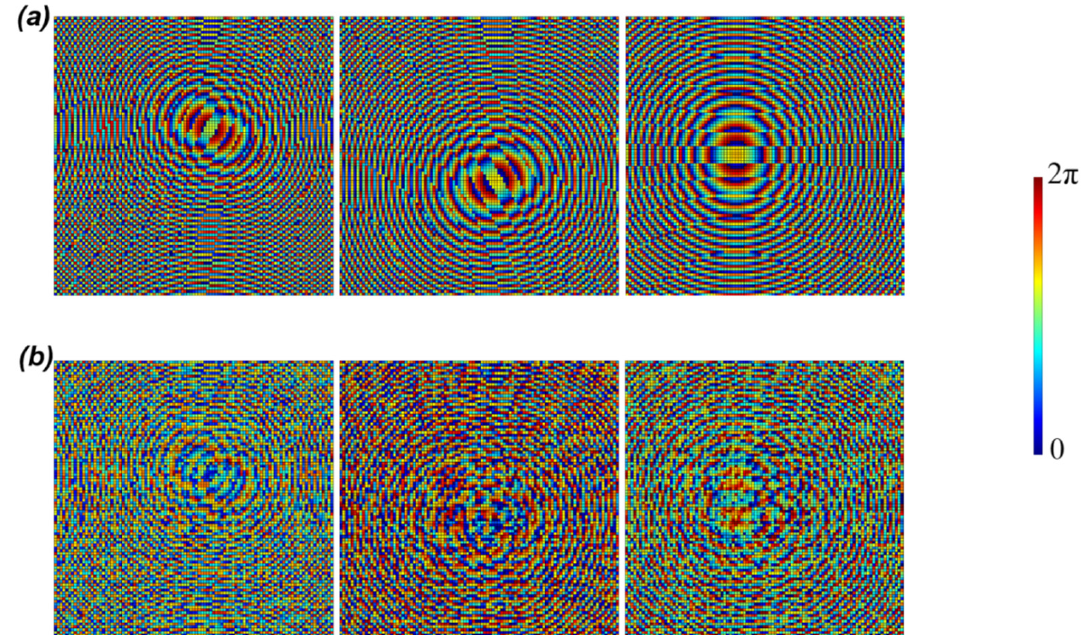
Figure 5. ( a ) From left to right, the ideal phase distributions corresponding to the three wavelengths B, G, and R, respectively, are shown; ( b ) From left to right, the real phase distributions corresponding to the three wavelengths B, G, and R, respectively, are shown.